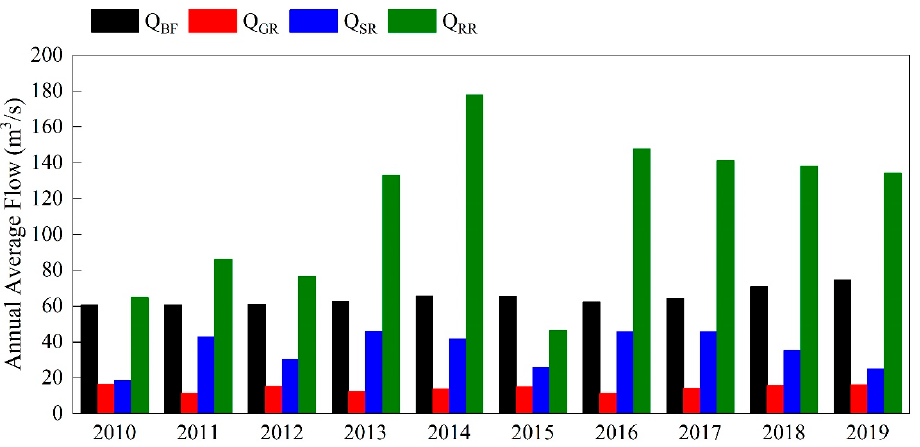
Figure 8. Average annual scenarios of main components such as baseflow (Q BF ), glacier melt runoff (Q GR ), rainfall-runoff (Q RR ), and snowmelt runoff (Q SR ) simulated by the SPHY model during 2010–2019.